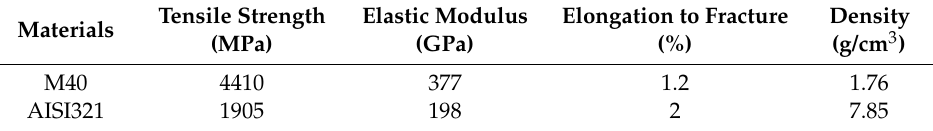
Table 1. Basic properties of in-plane reinforcement and interlaminar